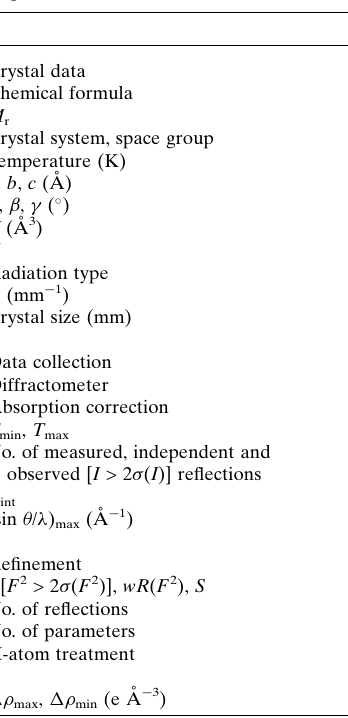
Table 4 Experimental